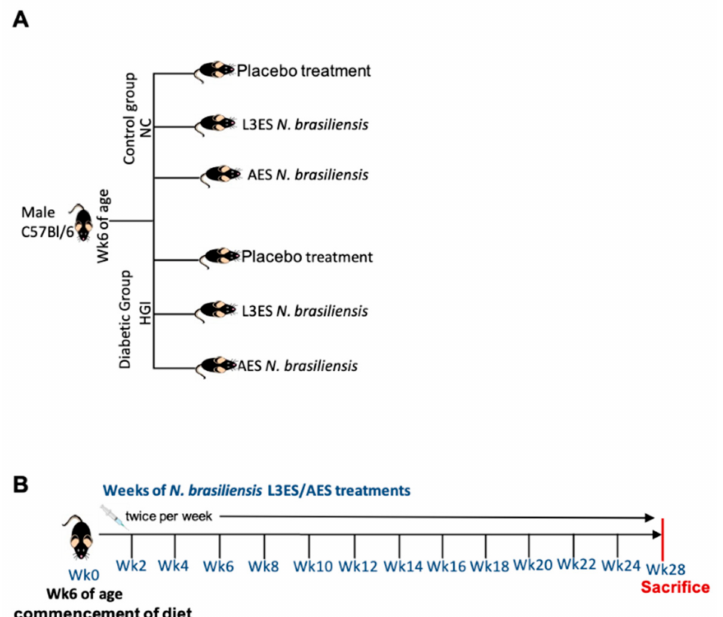
Figure 1. Experimental design and timeline for treatments of mice with Nippostrongylus brasiliensis third stage larvae (L3) or adult worm ( A ) excretory secretory proteins (ES). Six-week-old C57BL/6 mice were fed normal control (NC) or high glycaemic index (HGI) diets ( A ) and injected intra- peritoneally twice weekly with 1 mg/kg of L3ES or AES commencing at week 0 of the experiment and ending with sacrifice of the animals and tissue collection at week 28 ( B ). Food in each cage was weighed weekly and no differences were detected between diets or treated vs. untreated